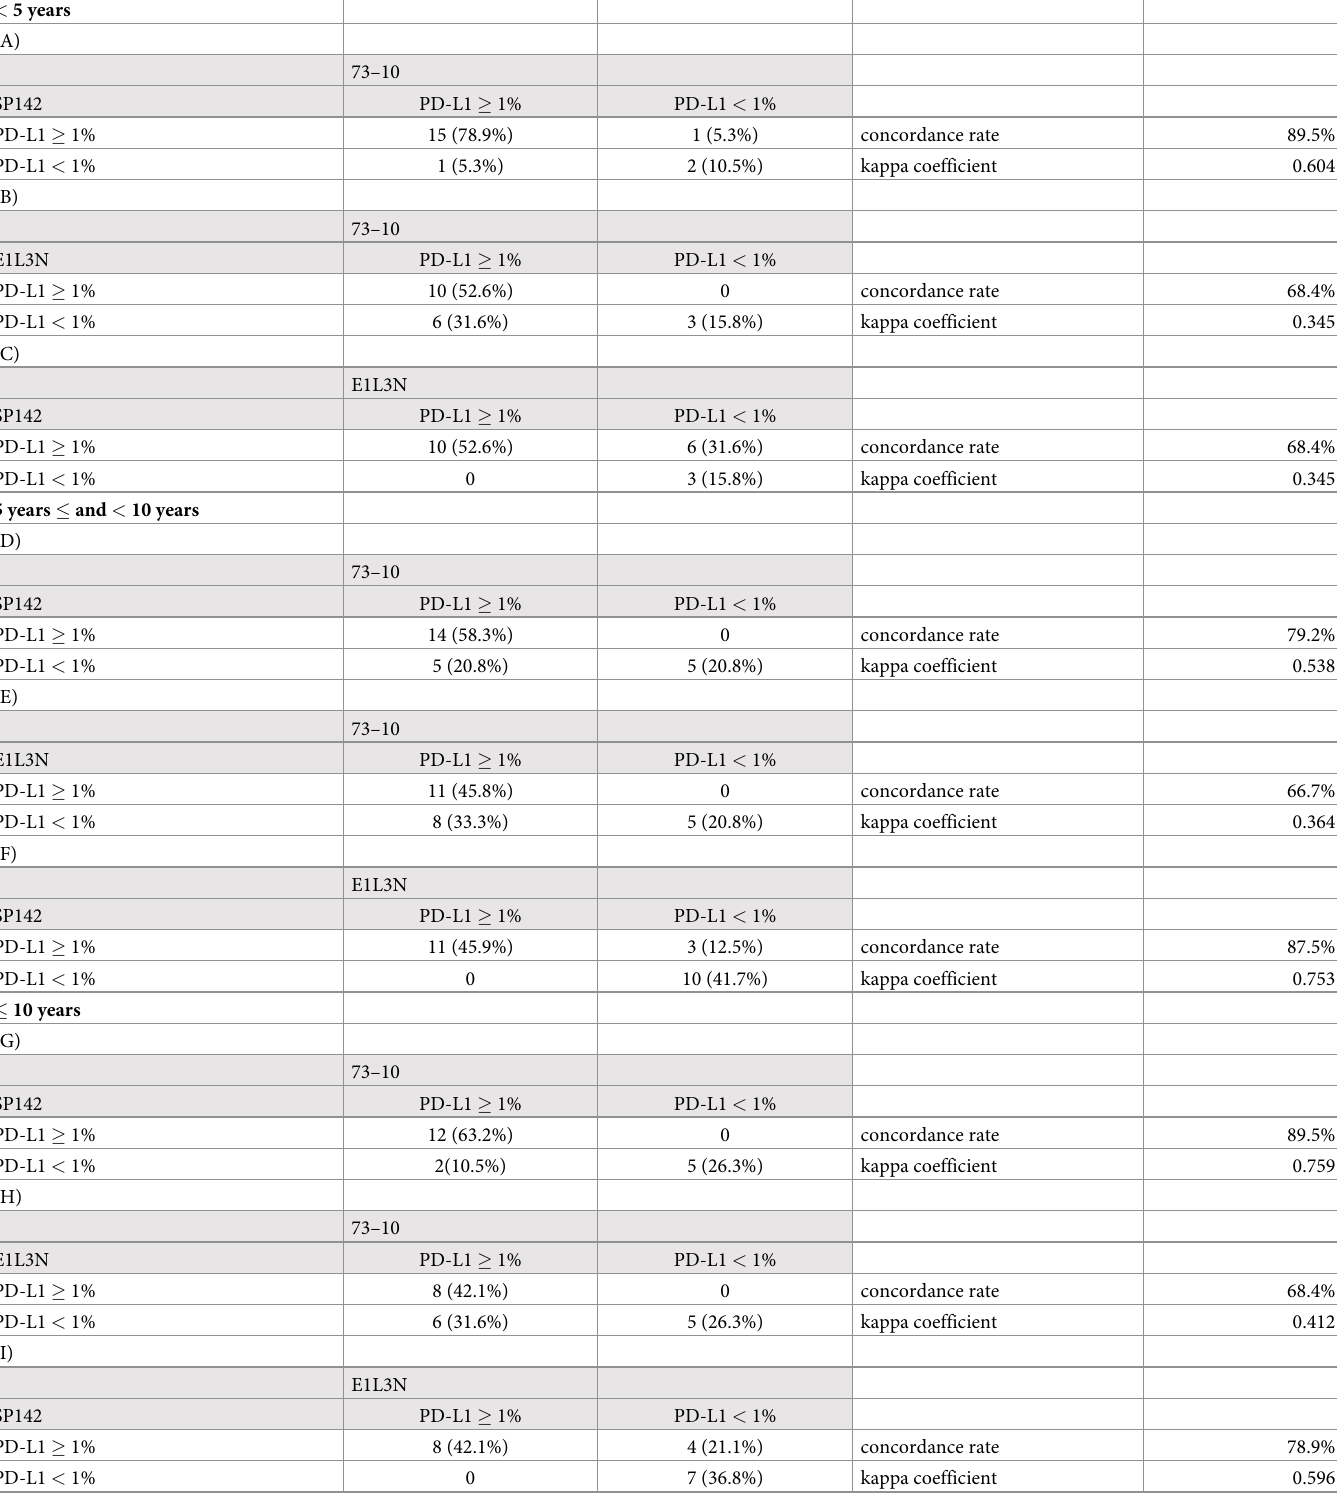
Table 4. Comparison of PD-L1 expression on ICs by 73–10, SP142, and E1L3N assays in sample